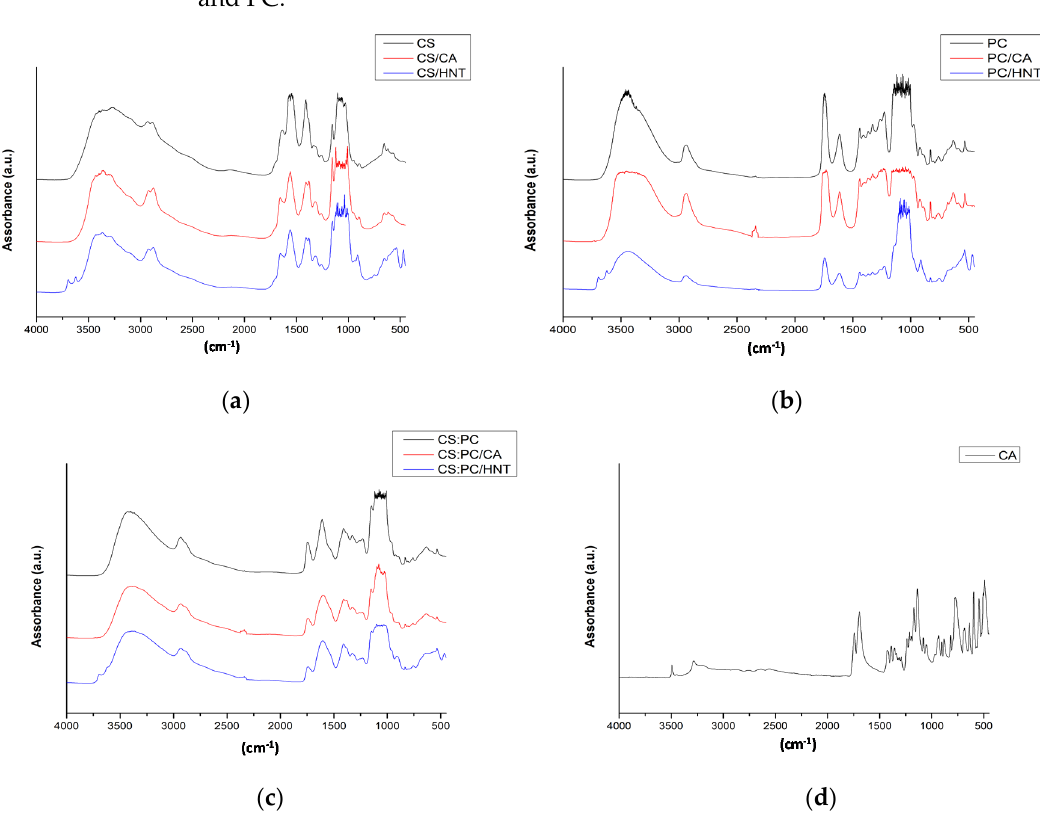
Figure 4. FT-IR spectra of biopolymer films containing citric acid (CA) or halloysite nanotubes (HNT) in different matrices: ( a ) chitosan, CS, ( b ) pectin, PC, ( c ) chitosan:pectin blend, CS:PC; ( d ) ATR-FTIR spectrum of neat CA.